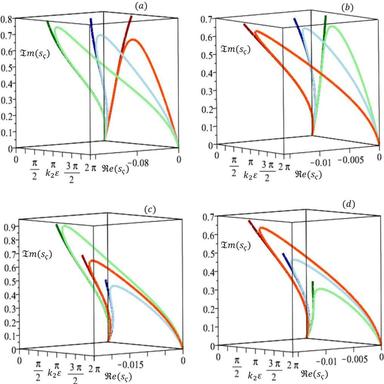
Dispersion functions associated to compressional waves travelling along e2. Comparison between the two homogenized models (dark line) and the heterogeneous one (light line); (a) is obtained by setting τ 1 ς = τ 2 ς = 2, η = 1, rρ = rE = 10, ν˜1 = ν˜2 = 0.2 and by varying the dimensionless elastic parameter γ = 1/10 (red curves), γ = 1/5 (blue curves) and γ = 1 (green curves); (b) is obtained by setting η = 1, rρ = rE = 10, ν˜1 = ν˜2 = 0.2, γ = 1/10 and by varying the dimensionless relaxation time τ 1 ς = τ